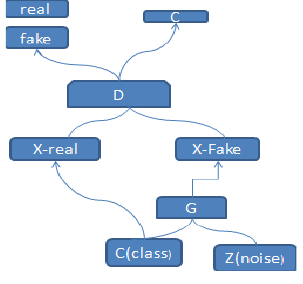
Fig.3 .The architecture of